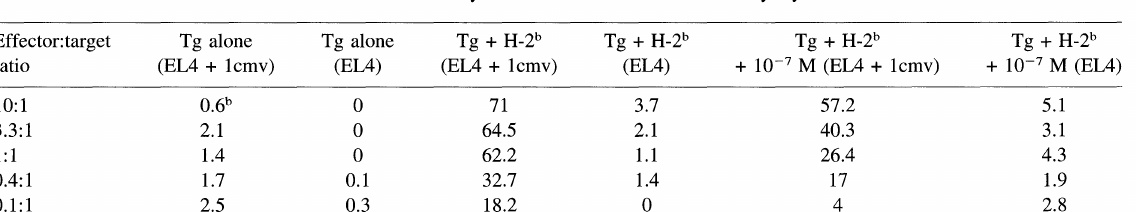
TABLE III Positively Selected CD4-CD8 Cells Are